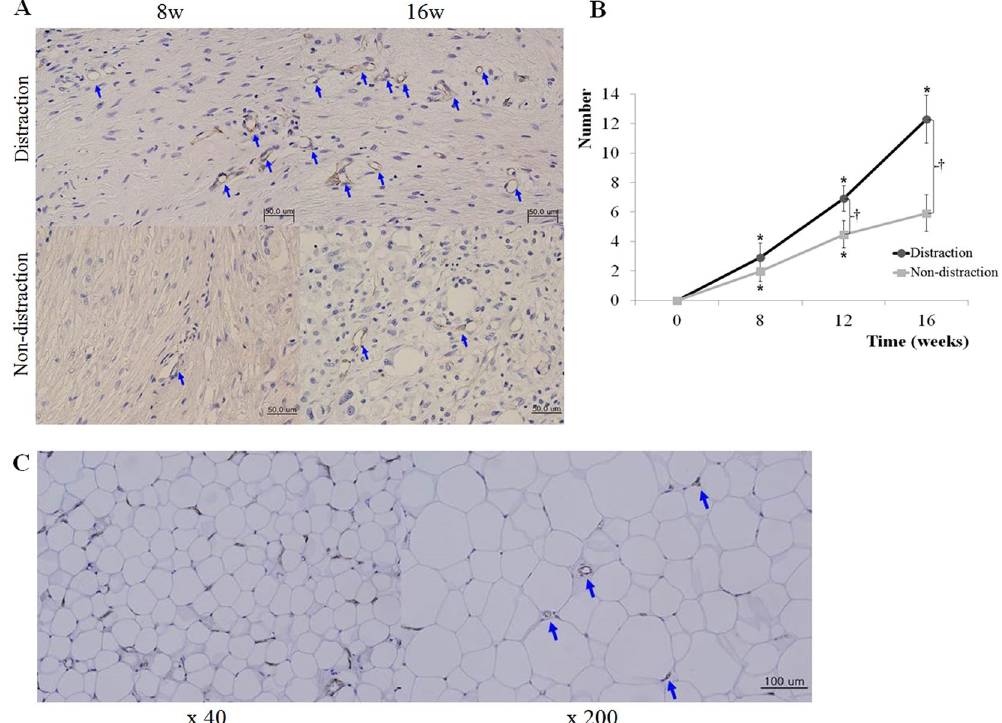
Figure 3. CD31 immunohistochemistry results showing evidence of angiogenesis. The arrows indicate endothelial lining with CD31-positive cells. Blood vessels were noted adjacent to adipocyte clusters at 8 weeks in the distraction group. The vessels increased in number and were evenly distributed at 16 weeks. In the non-distraction group, labeled cells were infrequent at 8 weeks. At 16 weeks, vessels were more apparent, but evidence of angiogenesis was less prominent than the distraction group ( A ). New blood vessels increased throughout the 16 weeks in the distraction group, and significant changes were noted at 8, 12, and 16 weeks. The non-distraction group exhibited increases up to 12 weeks. Comparative analysis revealed significant differences between groups at 12 and 16 weeks (p < 0.05) ( B ). In adipocyte clusters, the labeled capillaries were distributed throughout the uniform adipocytes. New blood vessels were noted among the adipocytes under high magnification in the distraction group, with prominent evidence of angiogenesis ( C ). * p < 0.05, compared with measurement at the previous time point. † p < 0.05, compared with the control